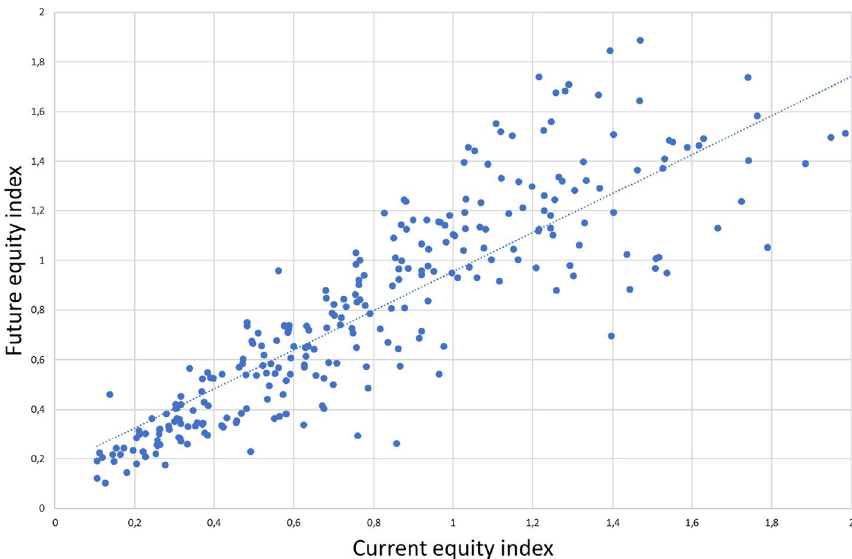
Fig. 4 Scatter plot with present and future equity index ( Source : INE 2019 agricultural census, GPP and authors’